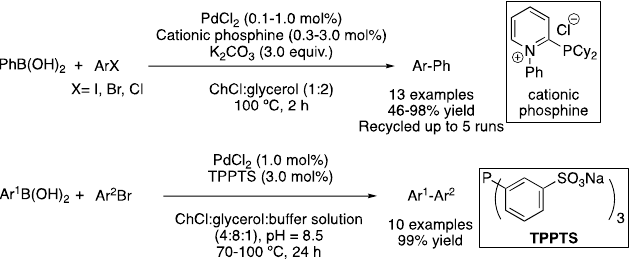
Figure 18. Phosphine ligands in cross-coupling reactions in DESs.